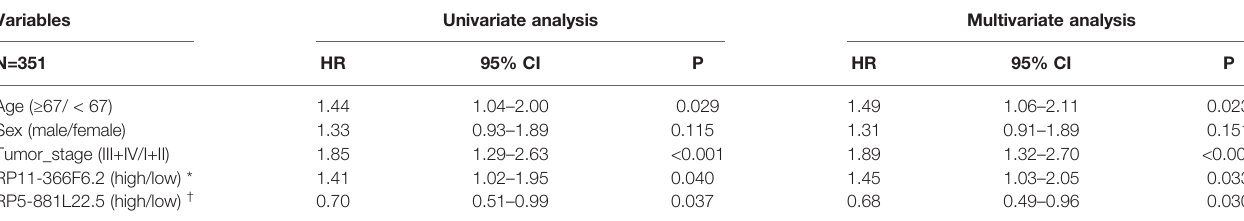
TABLE 1 | Univariate and multivariate Cox regression analysis of variables associated with gastric cancer (GC) patient survival. Variables Univariate